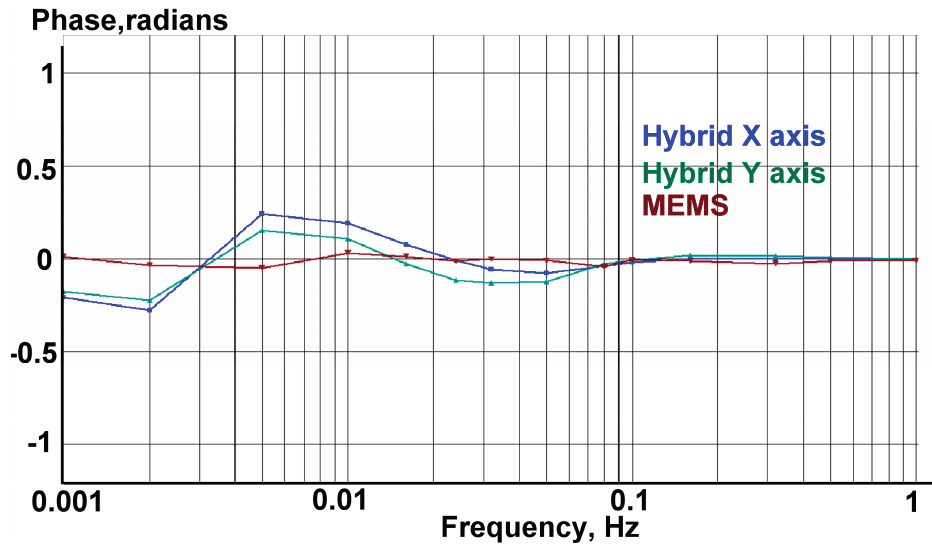
Figure 14. Measured phase response for two horizontal channels of the hybrid sensor (blue and teal) and a MEMS (dark red).